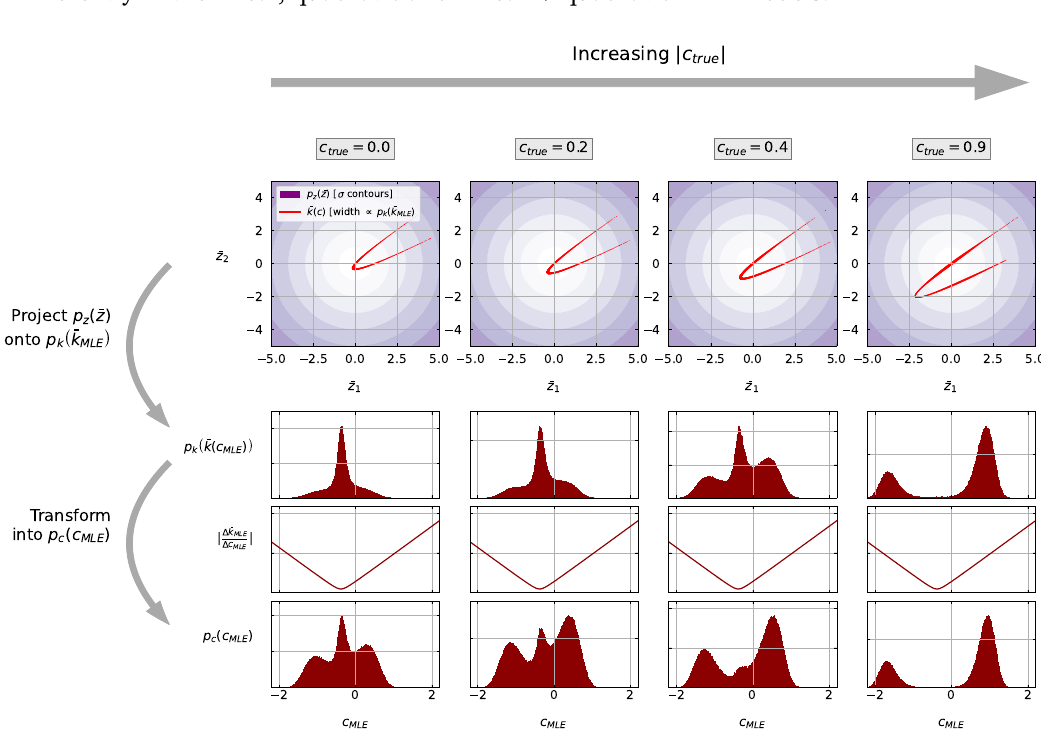
Figure 22: Visualisation showing how contours of the test-statistic q ferently in the linear, quadratic and ‘linear + quadratic” EFT models.